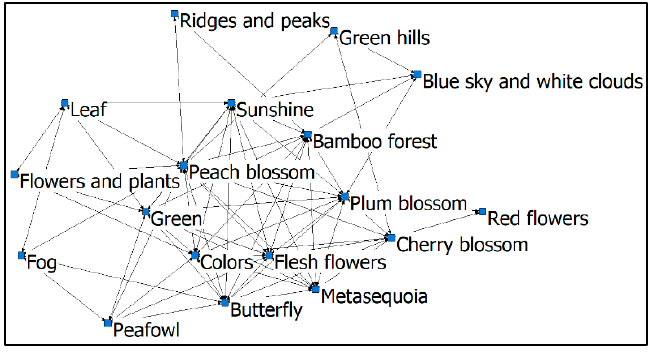
Figure 12. 4-1. Natural landscapes based on the visual interactive perception.